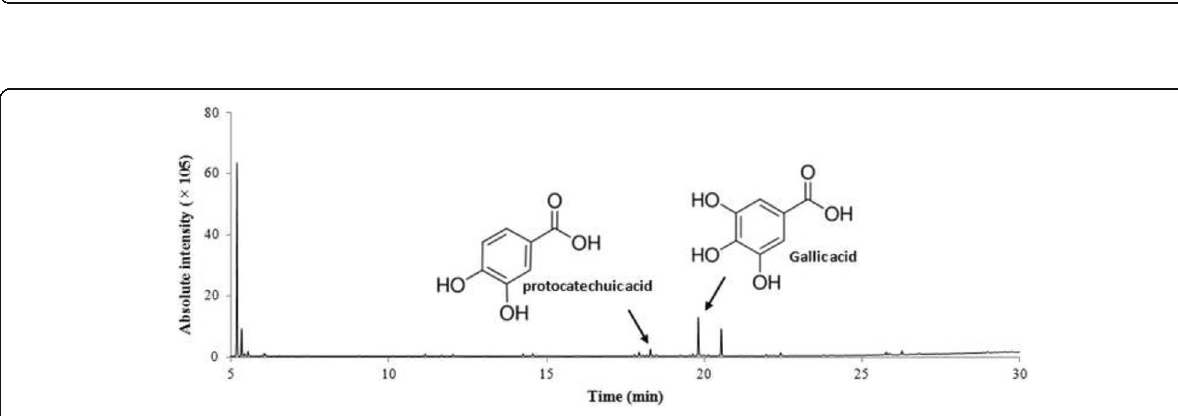
Fig. 5 GC-MS Chromatograms of the methanol extract